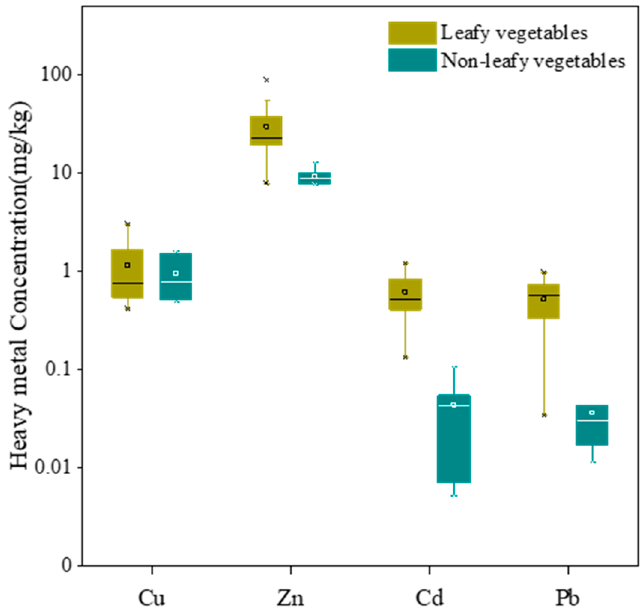
Figure 3. Box plots of heavy metal concentrations in vegetables (fresh weight). Middle band, box and whiskers represent the median, 25th and 75th percentile and 5th and 95th percentile, respectively. Squares represent means, whereas ‘‘*’’ represent extreme values.